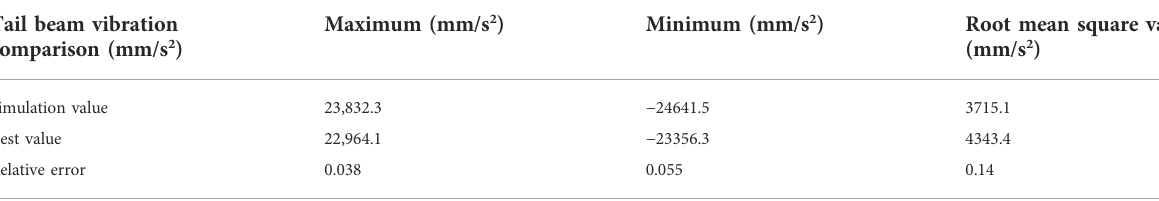
TABLE 6 Time-domain signal characteristics of tail beam vibration acceleration. Tail beam vibration comparison (mm/s 2